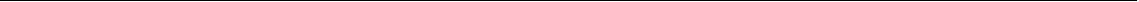
Fig. 10 A complex interaction model for pathogenicity of the 16p11.2 deletion. a Examples of interactions from quantitative phenotyping data observed with pairwise knockdown of genes. Blue lines indicate modulation of GeneB expression in wild-type fl ies, while orange lines indicate modulation of GeneA expression when GeneB is also knocked down. GeneA knockdowns that have the same phenotype with or without GeneB knockdown indicate no interaction between the two genes (left). Epistatic interactions between fl y homologs occur when the change in effect for two-hit knockdown fl ies compared to GeneA knockdown is less severe (suppressor) or more severe (enhancer) than that for GeneB knockdown compared to control (center). When the effect of GeneB knockdown is the same in wild-type fl ies and fl ies with GeneA knockdown, the two genes show an additive interaction (right). b Summary table listing all validated interactions with 16p11.2 Drosophila homologs found using screening of eye phenotypes. For epistatic interactions between fl y homologs, blue- colored genes represent suppressors while red-colored genes indicate enhancers of the one-hit phenotype. Epistatic interactions with available Flynotyper data were con fi rmed using two-way ANOVA tests ( p < 0.05, df = 1, F > 4.5202; see Supplementary Data 8). Bold genes are annotated for cell proliferation/ cell cycle GO terms. *indicates observed cell organization/proliferation defects in the developing eye, and † indicates observed axonal targeting defects. c A model of pathogenicity of 16p11.2 deletion inferred from fl y studies. The knockdown of individual 16p11.2 homologs in Drosophila contributes towards various neuronal or developmental phenotypes. However, pairwise knockdown of 16p11.2 homologs, or knockdown of 16p11.2 homologs with other modi fi er genes, leads to enhancement, suppression, or rescue of these phenotypes, ultimately resulting in variable phenotypes dependent on the extent